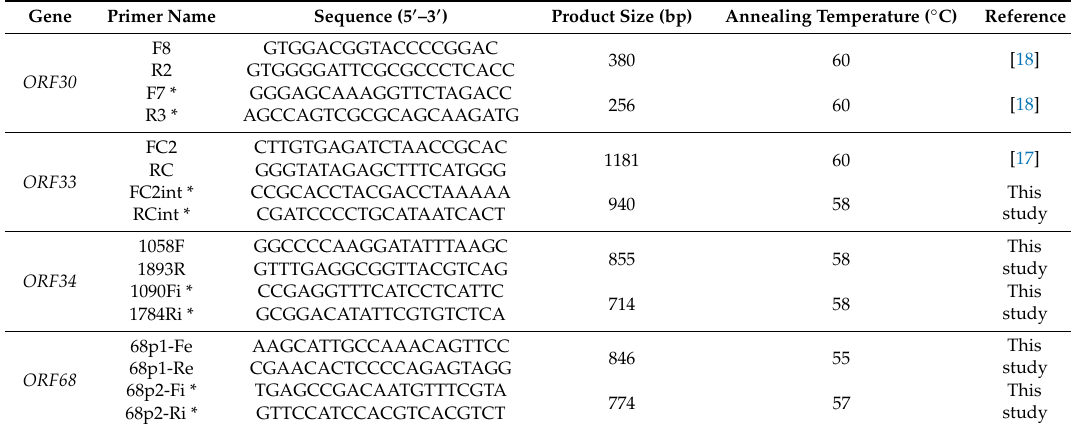
Table 2. Primers used for PCR and sequencing